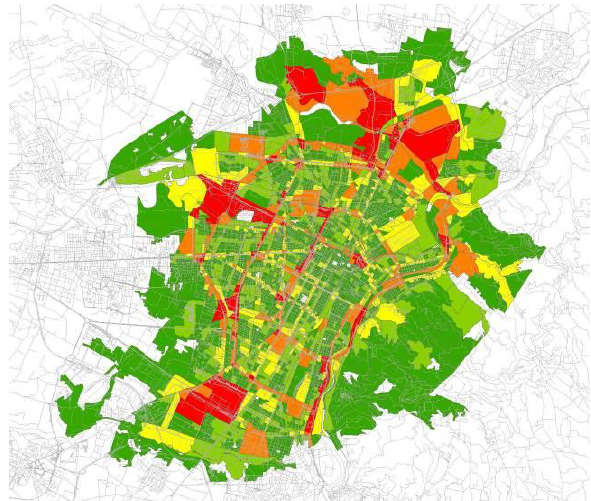
Figure 17. Census areas symbolised by total length of travel path crossing them (green colour = lower values, red colours = higher